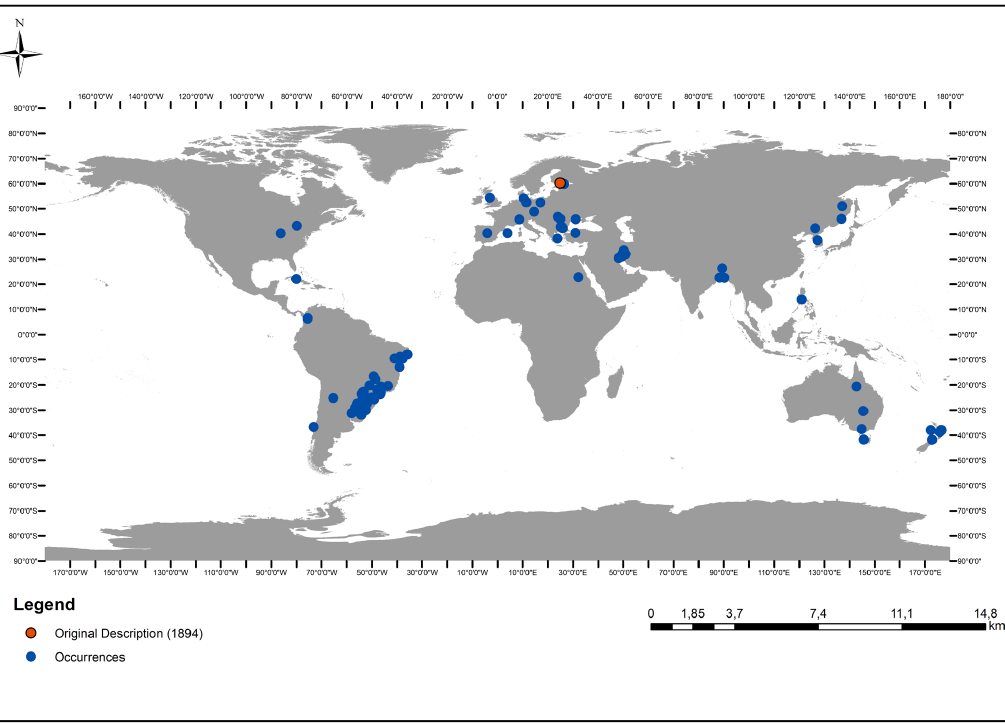
Figure 12. Occurrence of Ceratium furcoides in the